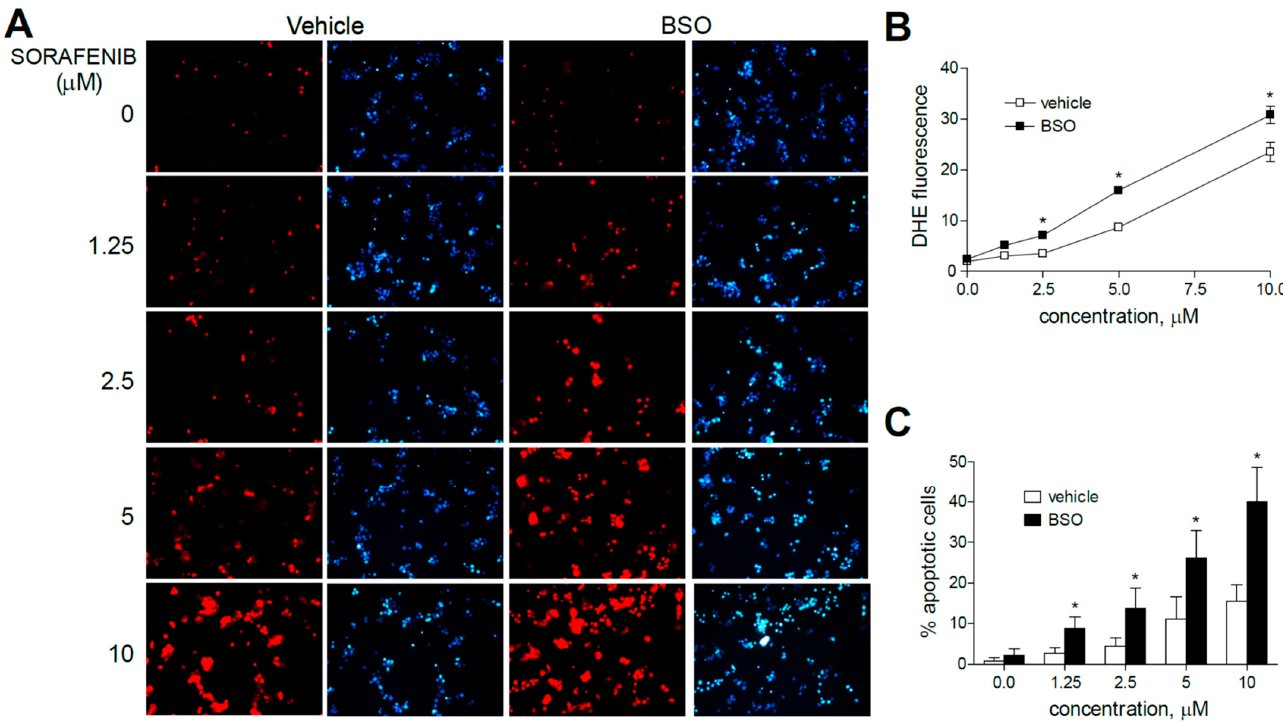
Figure 2. Superoxide production, increased by sorafenib in liver cancer cells, is enhanced by GSH reduction. ( A ) Repre- sentative fluorescence images ( n = 10) after superoxide detection (DHE, red) and nuclear (Hoechst 33258, blue) staining of HepG2 cells at increasing concentrations of sorafenib. ( B ) Quantification of DHE fluorescence in sorafenib-treated cells was analyzed using Image J software. ( C ) Percentage of apoptotic nuclei was measured ( n = 3). * p < 0.05 vs. control.